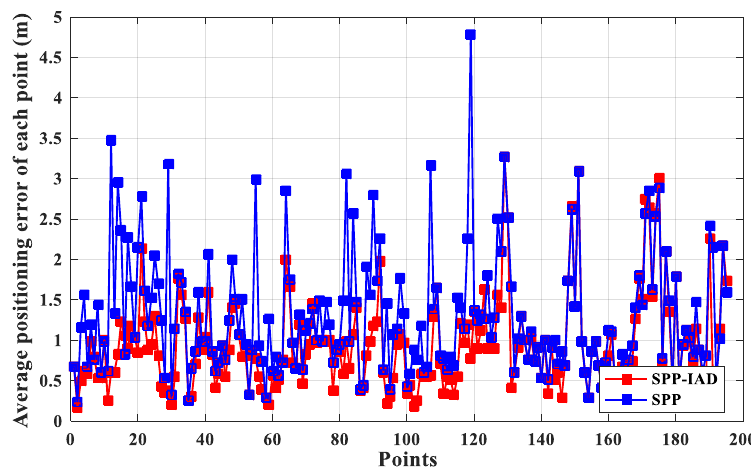
Figure 16. Average positioning error of each testing point.